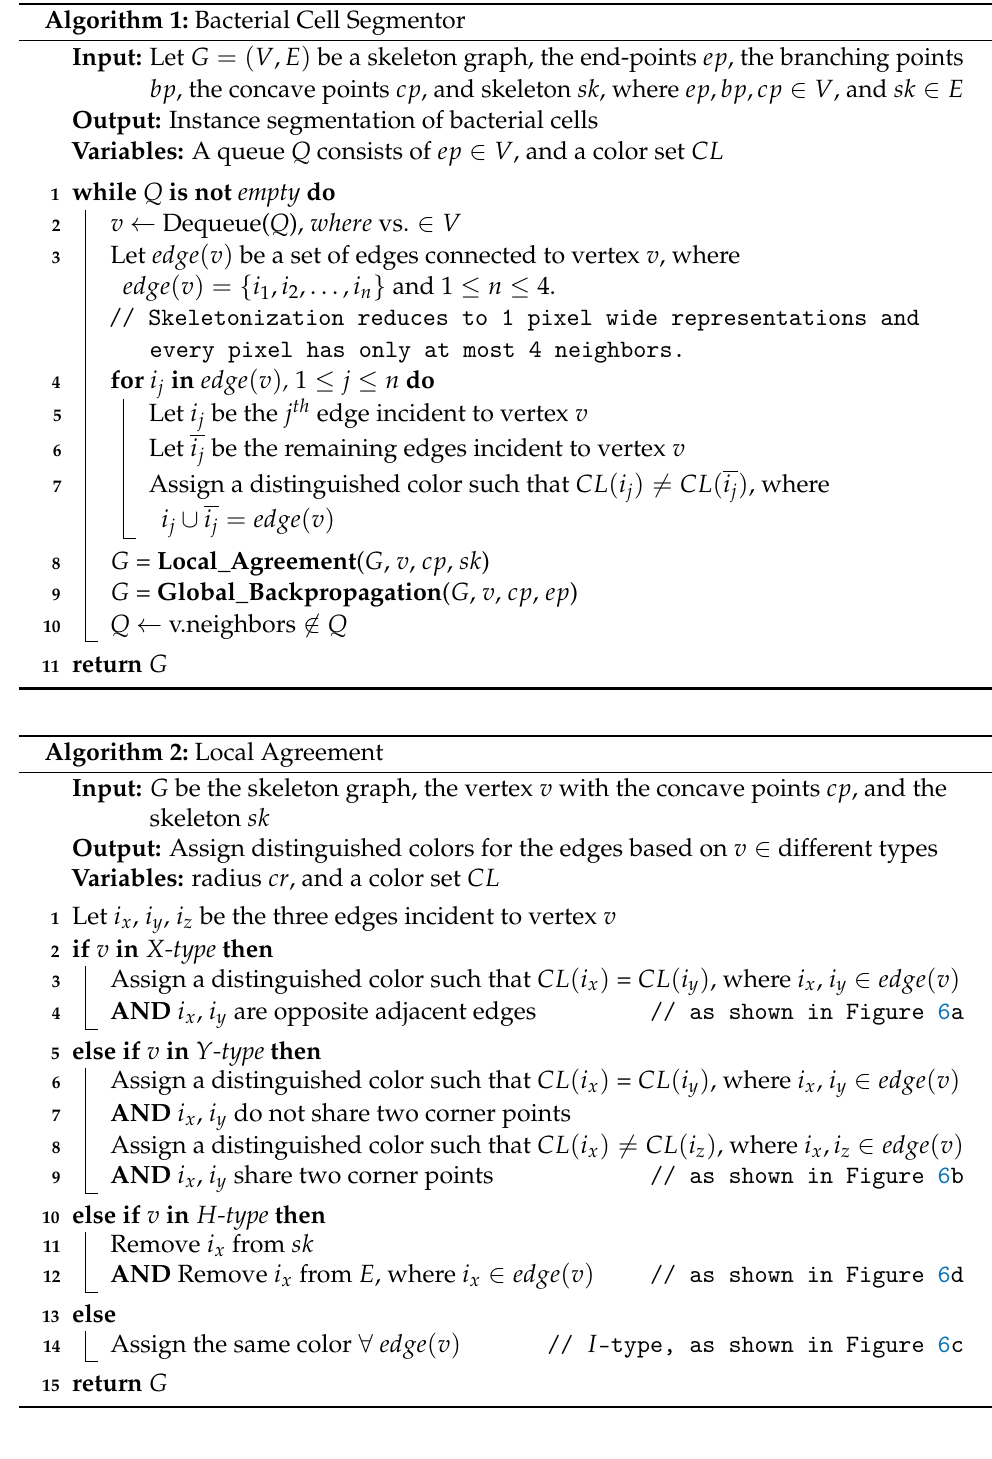
Algorithm 1: Bacterial Cell